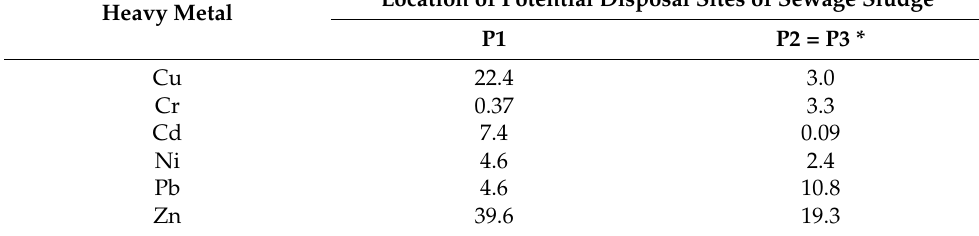
Table 4. Content of the element from the heavy metal group in agricultural soils of ´Swi˛etokrzyskie Voivodeship, mg · kg − 1 d.m.